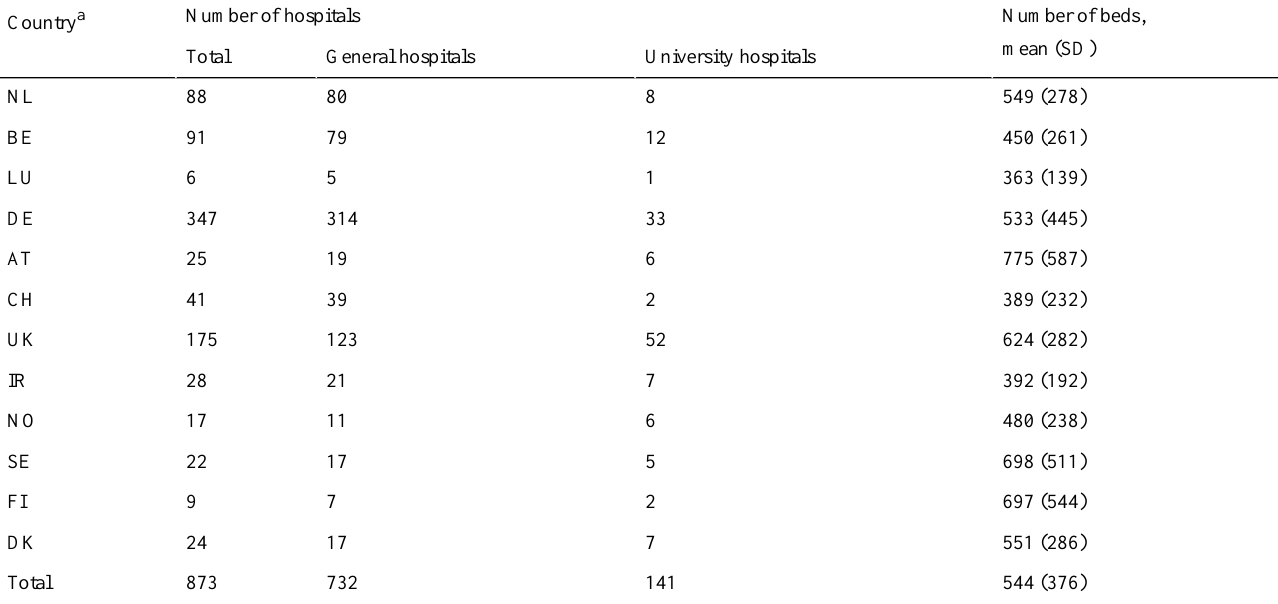
Table 2. Hospitals included in the analysis and their general details.